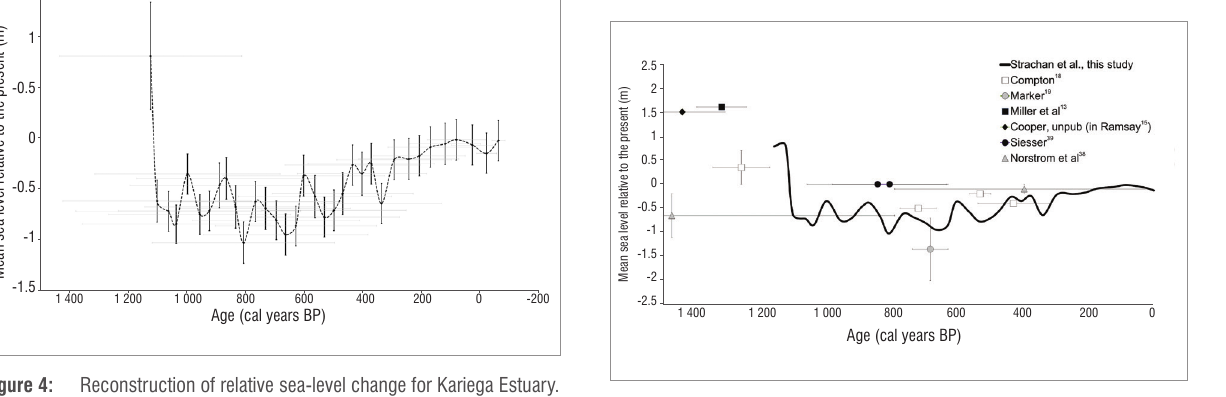
Figure 5: Late Holocene sea-level curve from Kariega Estuary com pared with previously published sea-level evidence from southern Africa.